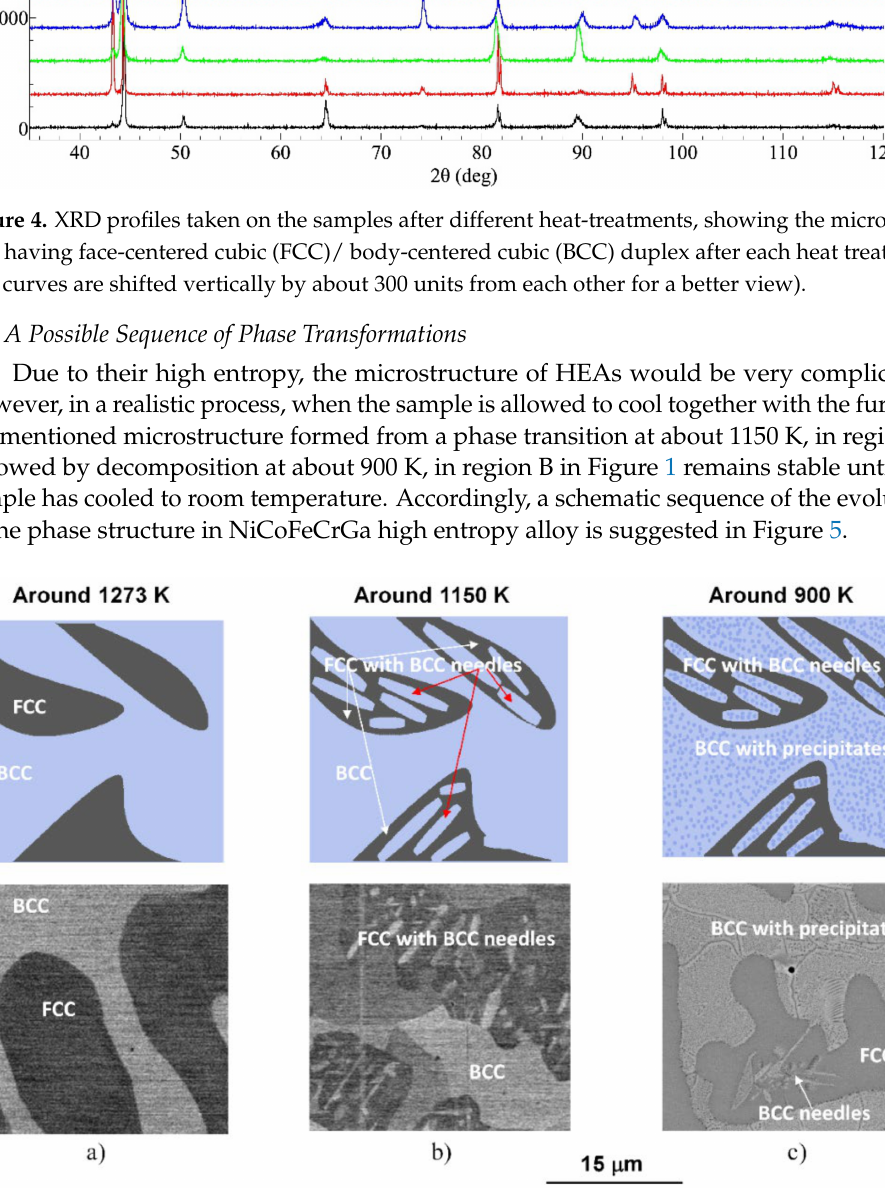
Figure 5. Schematic sequence of the evolution of the phase structure during slow cooling (top row) and the corresponding SEM micrographs (bottom row) taken on the samples heat-treated under conditions of ( a ) 1273 K for 1 h and WQ, ( b ) 1150 K for 1 h and WQ and ( c ) 1150 K for 1 h and slowly cooling with the